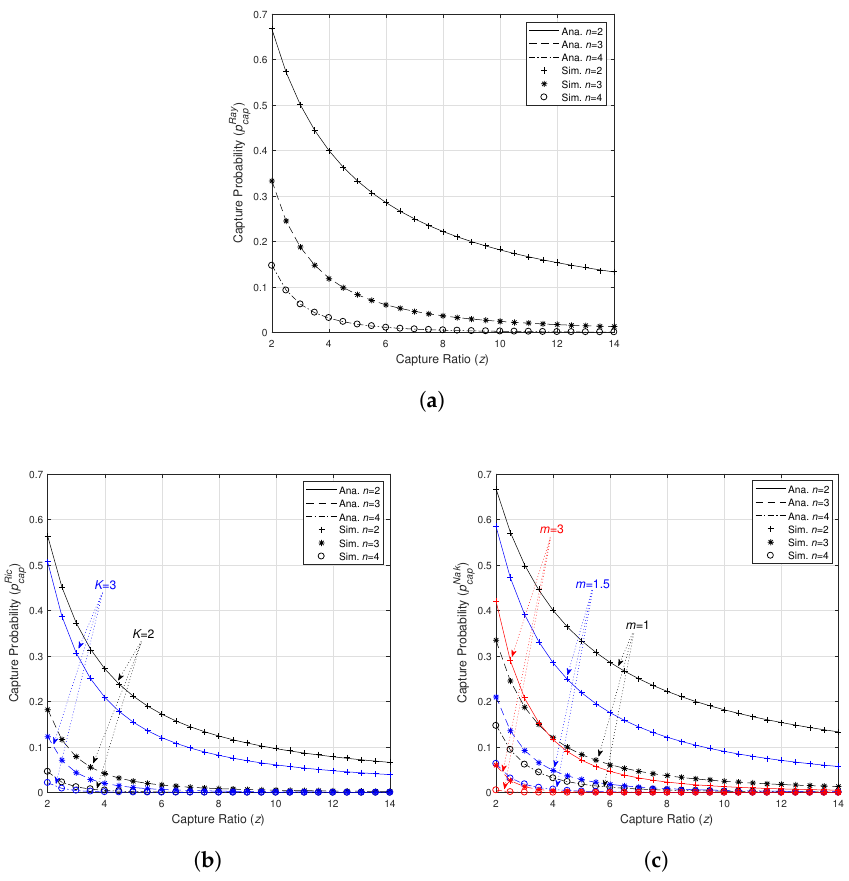
Figure 2. Capture (cap) probabilities when n = 2,3,4. ( a ) Rayleigh (Ray) fading; ( b ) Rician (Ric) fading for K = 2,3; ( c ) Nakagami- m (Nak) fading for m = 1,1.5,3. Ana., analysis; Sim., simulation.